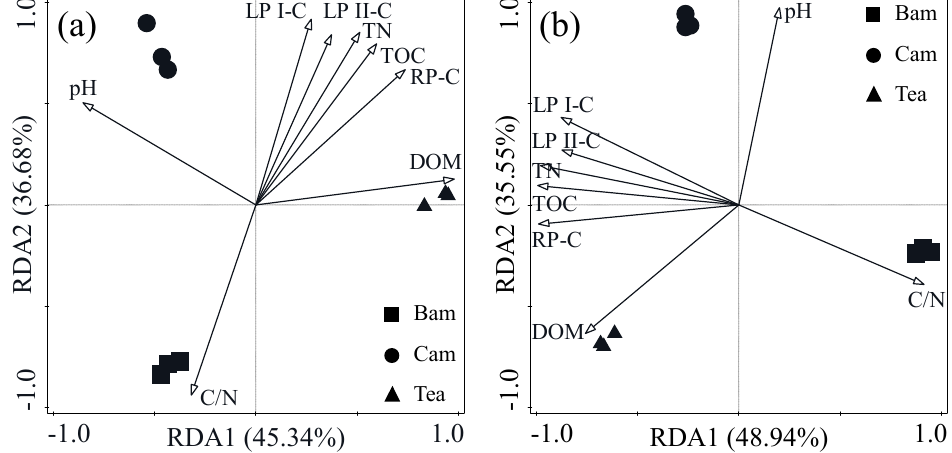
Figure 6. Redundancy analysis (RDA) of soil bacterial ( a ) and fungal ( b ) communities from bamboo (Bam), camphor (Cam), and tea (Tea) plantations. TOC, total organic carbon; TN, total nitrogen; C/N, ratio of carbon to nitrogen; LP I-C, labile pool I of soil organic carbon; LP II-C, labile pool II of soil organic carbon; RP-C, recalcitrant pool of soil organic carbon; DOM, dissolved organic